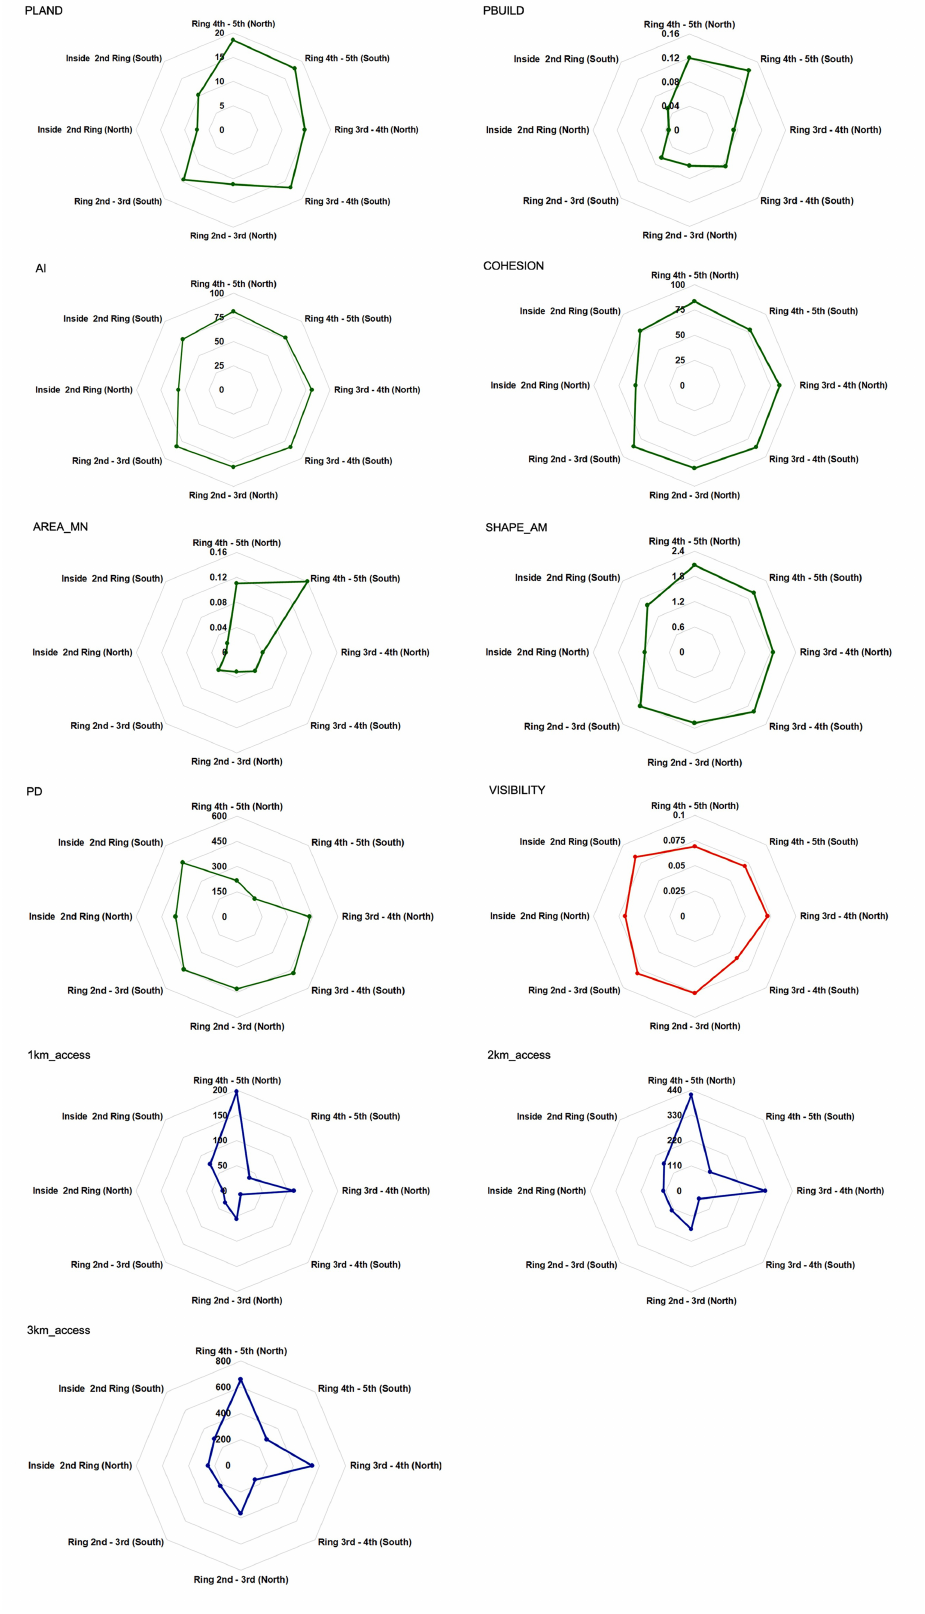
Figure 6. There are significant north-south differences between rings in the equity of community green